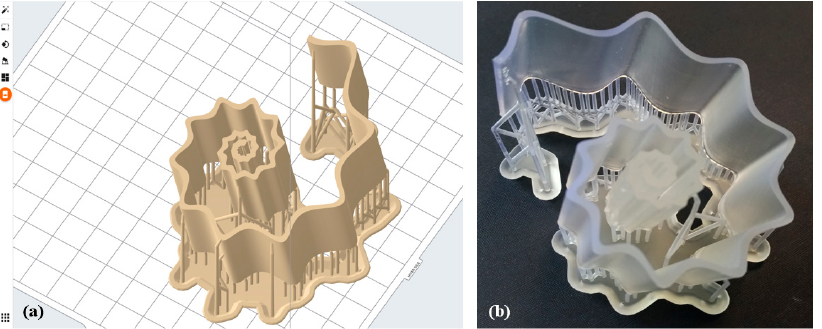
Figure 3. SsDRA fabrication: ( a ) The final model of the SsDRA generated in the Formlabs Preform V3.12.2 software environment; ( b ) The 3D-printed SsDRA prototype made of clear resin (DRA1)